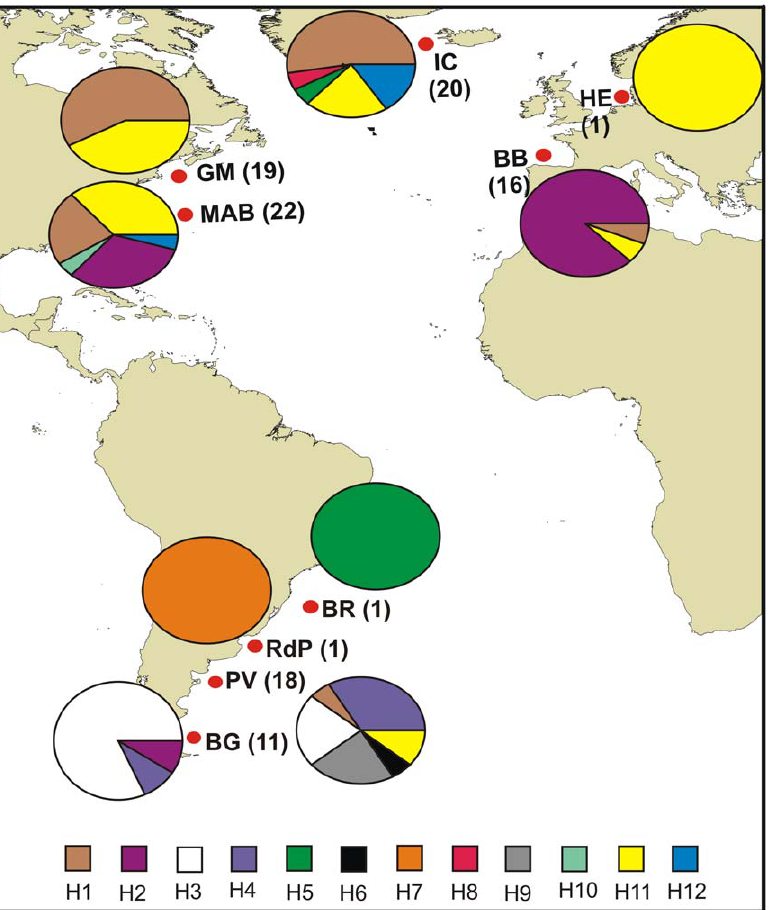
Figure 3. Distribution and frequence of Oithona similis kind sequence. Pie diagrams depicting the kind sequence frequencies of a 51 bp region of 28S for samples of O. similis collected from Gulf of Maine (GM), Iceland (IC), Middle Atlantic Bight (MAB), Bay of Biscay (BB), Penı´nsula Valde´s (PV) and Bahı´a Grande (BG). Sample size (n= number of individual copepods) in each location. The twelve O. similis sequence types (H1–H12) are represented by different colours. References in the figure.